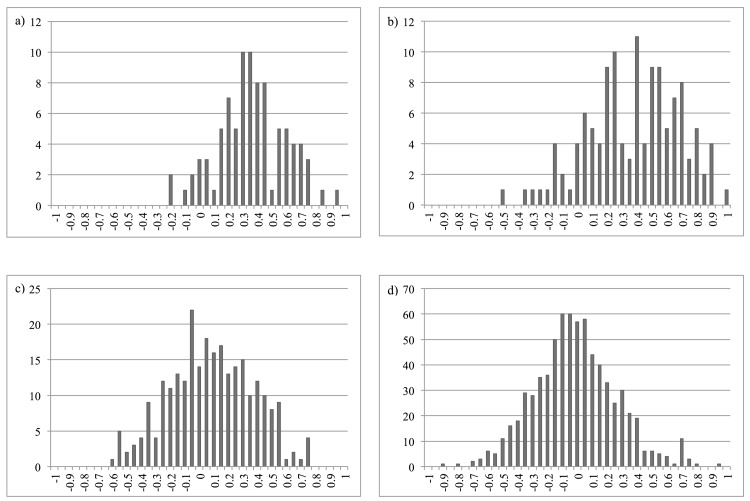
R-value distributions of regent honeyeaters of known pedigree at Taronga Zoo for a) parents and offspring (mean R-value 0.3367); b) full-sibs (mean R-value 0.3498); c) half-sibs (mean R-value 0.0578); and d) unrelated birds (mean R-value -0.0369).